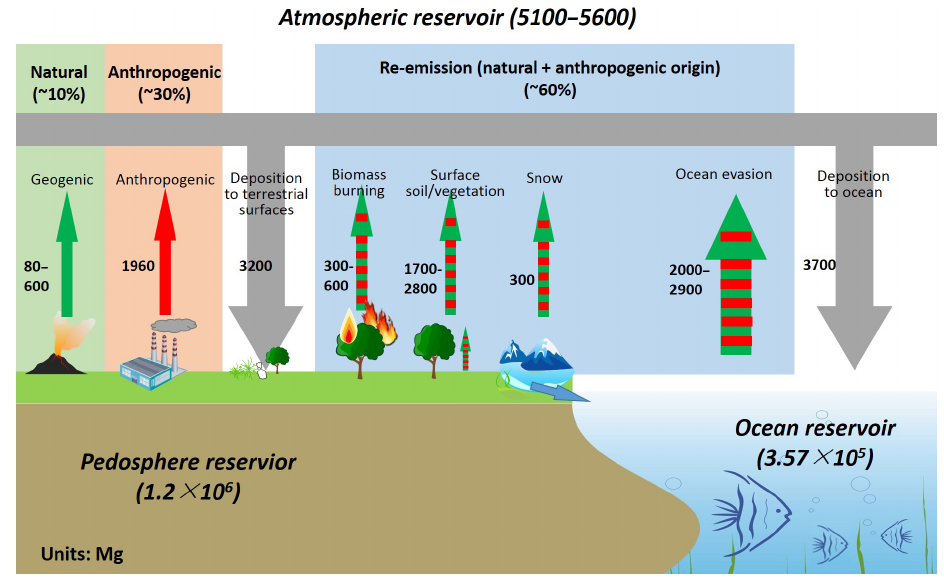
Figure 1. The most recent Hg reservoirs and global atmosphere Hg inventory illustrating the exchange flux between atmosphere and Earth surfaces. Adapted from Selin (2009); Gustin and Jaffe (2010); Soerensen et al. (2010); Corbitt et al. (2011); Mason et al. (2012); AMAP/UNEP